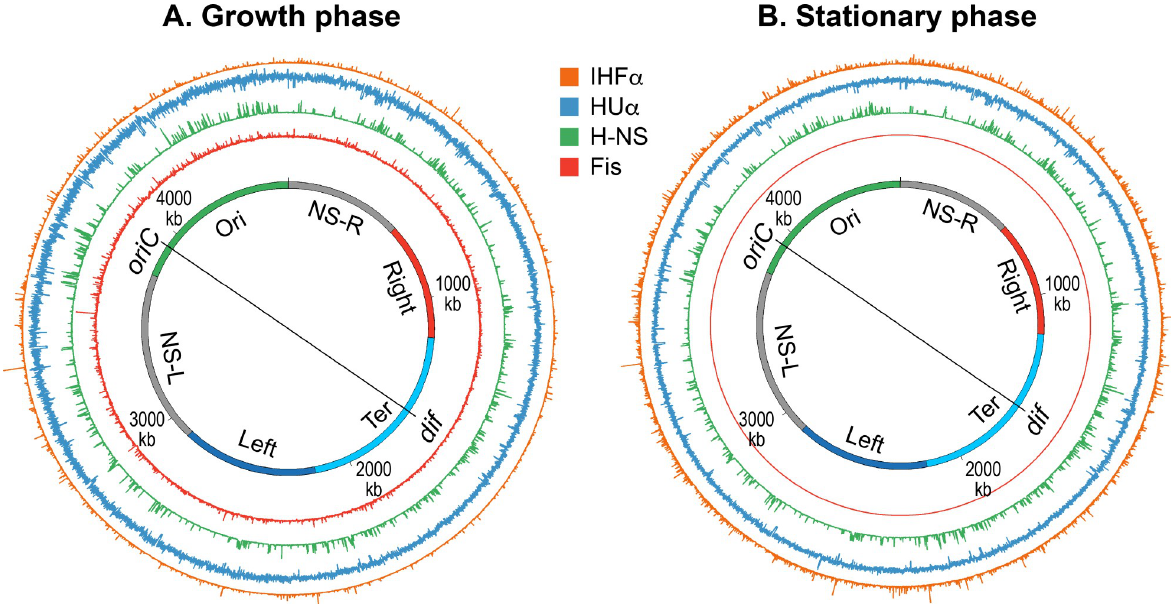
Fig 3. Genome-wide occupancy of nucleoid-associated proteins (NAPs) of E . coli . A. The circular layout of the E . coli genome (as shown in Fig 1A) additionally depicting the genome occupancy of indicated NAPs in the growth phase. B. The genome occupancy of indicated NAPs in the stationary phase. The genome layout is the same as in A. The genome occupancy of each NAP, determined by ChIP-Seq, is plotted as a histogram (bin size 300 bp) in which the bar height is indicative of relative binding enrichment. The figures were prepared in Circos/0.69–6 using the data from [46,